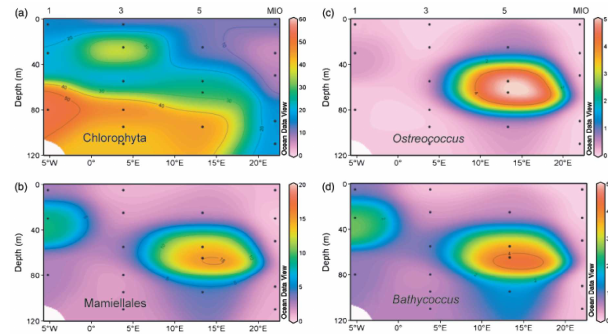
Fig. 10. Longitudinal differences in the distribution of selected autotrophic picoeukaryotes during the cruise PROSOPE from Gibraltar to the Southern Cretan Sea in September 1999. The distribution of the different taxa is represented as their percentage to the total eukaryotes estimated with quantitative PCR. Chlorophytes were abundant in deep and intermediate layers in the WMS, whereas Ostreococcus , Bathycoccus and other Mamiellales were only abundant at intermediate depths in the Sicily Channel. Reproduced with permission from Marie et al. (2006).